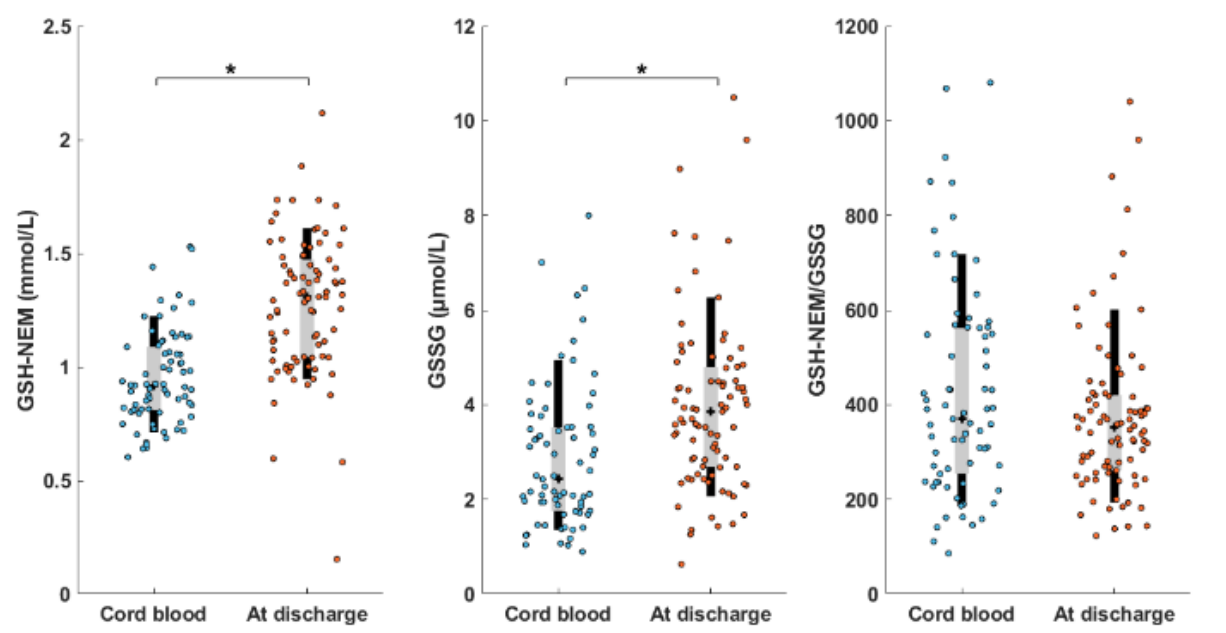
Figure 5. GSH-NEM and GSSG concentrations, and the GSH-NEM/GSSG of cord blood and blood samples collected at discharge. Black bars represent 10th–90th percentile; grey bars represent in- terquartile range (I–III), + represents median values. Note: * indicates p -value < 0.001; Wilcoxon rank sum test.